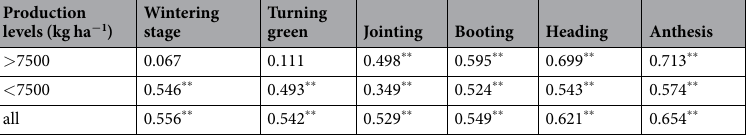
Production levels (kg ha − 1 )